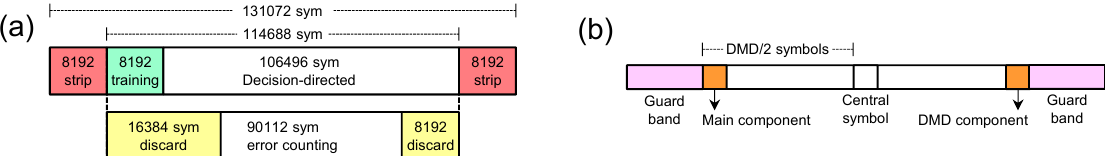
Figure 4. ( a ) Diagram of a simulated data trace, showing the symbols stripped to avoid errors due to circular convolutions and the traning sequence. ( b ) Configuration of the equalizer to optimize the numbers of taps and hence reduce the simulation time.